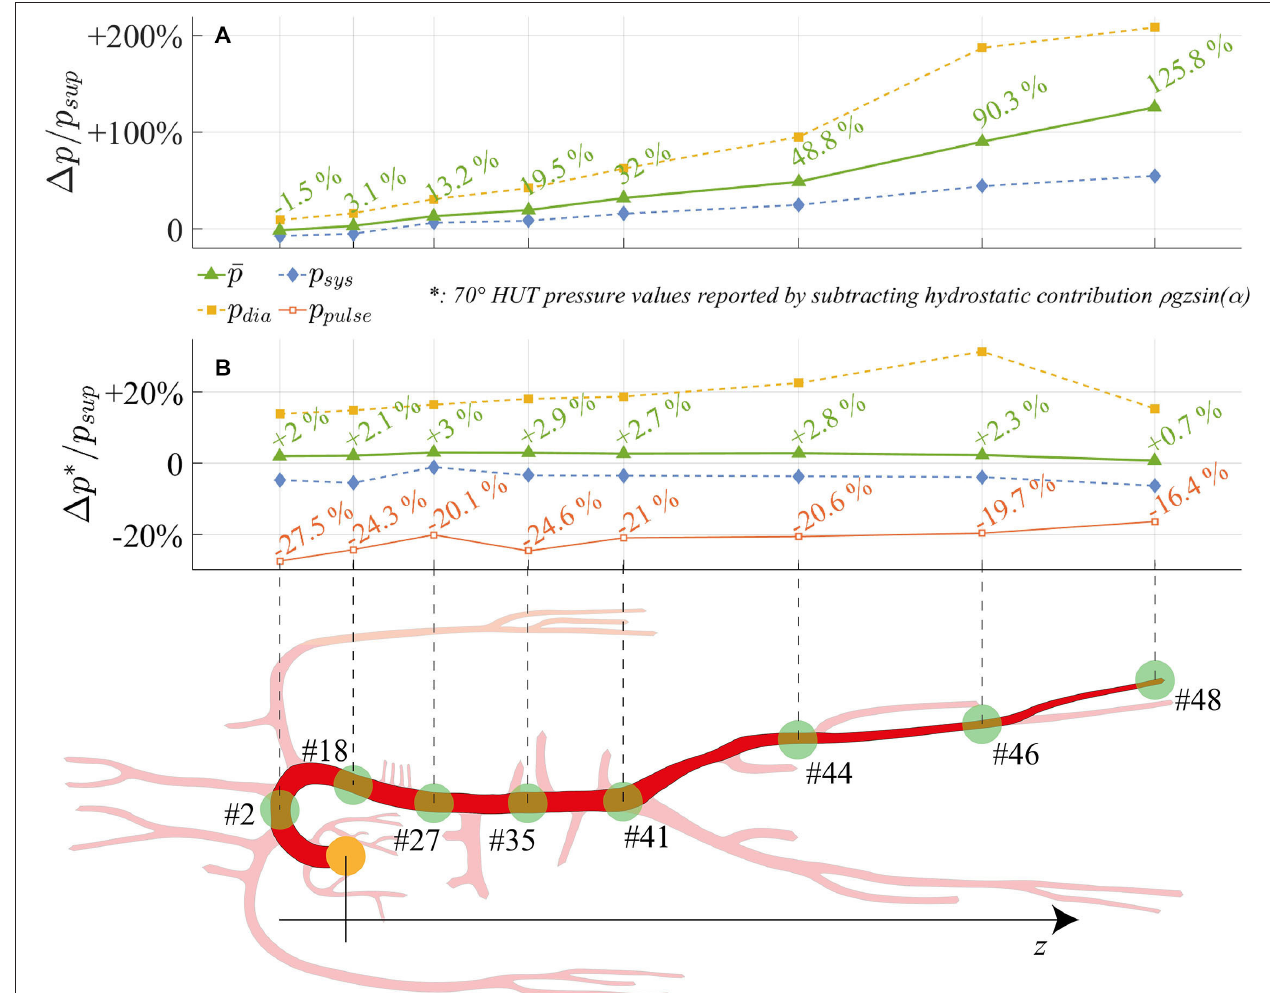
FIGURE 6 | Relative variation between 70 ◦ HUT and supine condition for steady-state pressures (systolic, mean, diastolic, pulse pressure) along the aorta and legs large arteries: the hydrostatic contribution is (A) taken into account ( 1 p / p ) and (B) neglected ( 1 p ∗ / p ). z is the longitudinal body axis.